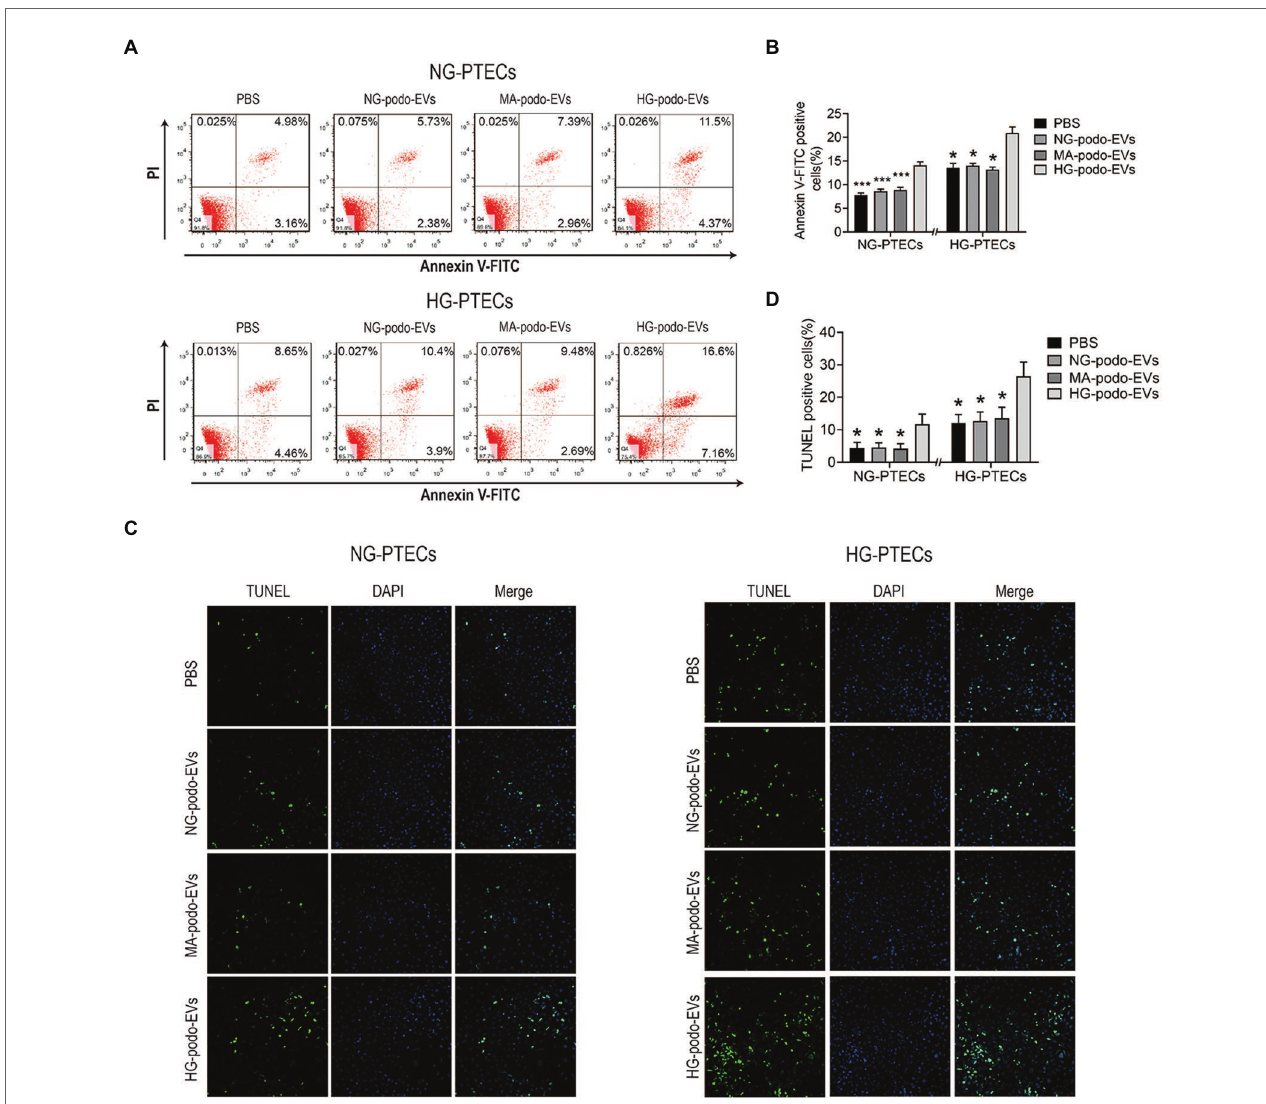
FIGURE 3 | EVs from HG-treated podocytes induced apoptosis of PTECs. Podocytes EVs were incubated with NG/HG-treated PTECs, and the proportion of apoptotic cells was determined by flow cytometry and TUNEL staining. (A) Apoptosis was examined using flow cytometry. (B) Quantification of Annexin V-FITC positive cells ( n = 4). (C) Apoptosis was detected using TUNEL staining. (D) Quantification of TUNEL positive cells. * p < 0.05 vs. HG-podo-EVs group; *** p < 0.001 vs. HG-podo-EVs group. HG, high glucose; MA, mannitol; NG, normal glucose; podo, podocytes; PTECs, proximal tubular epithelial